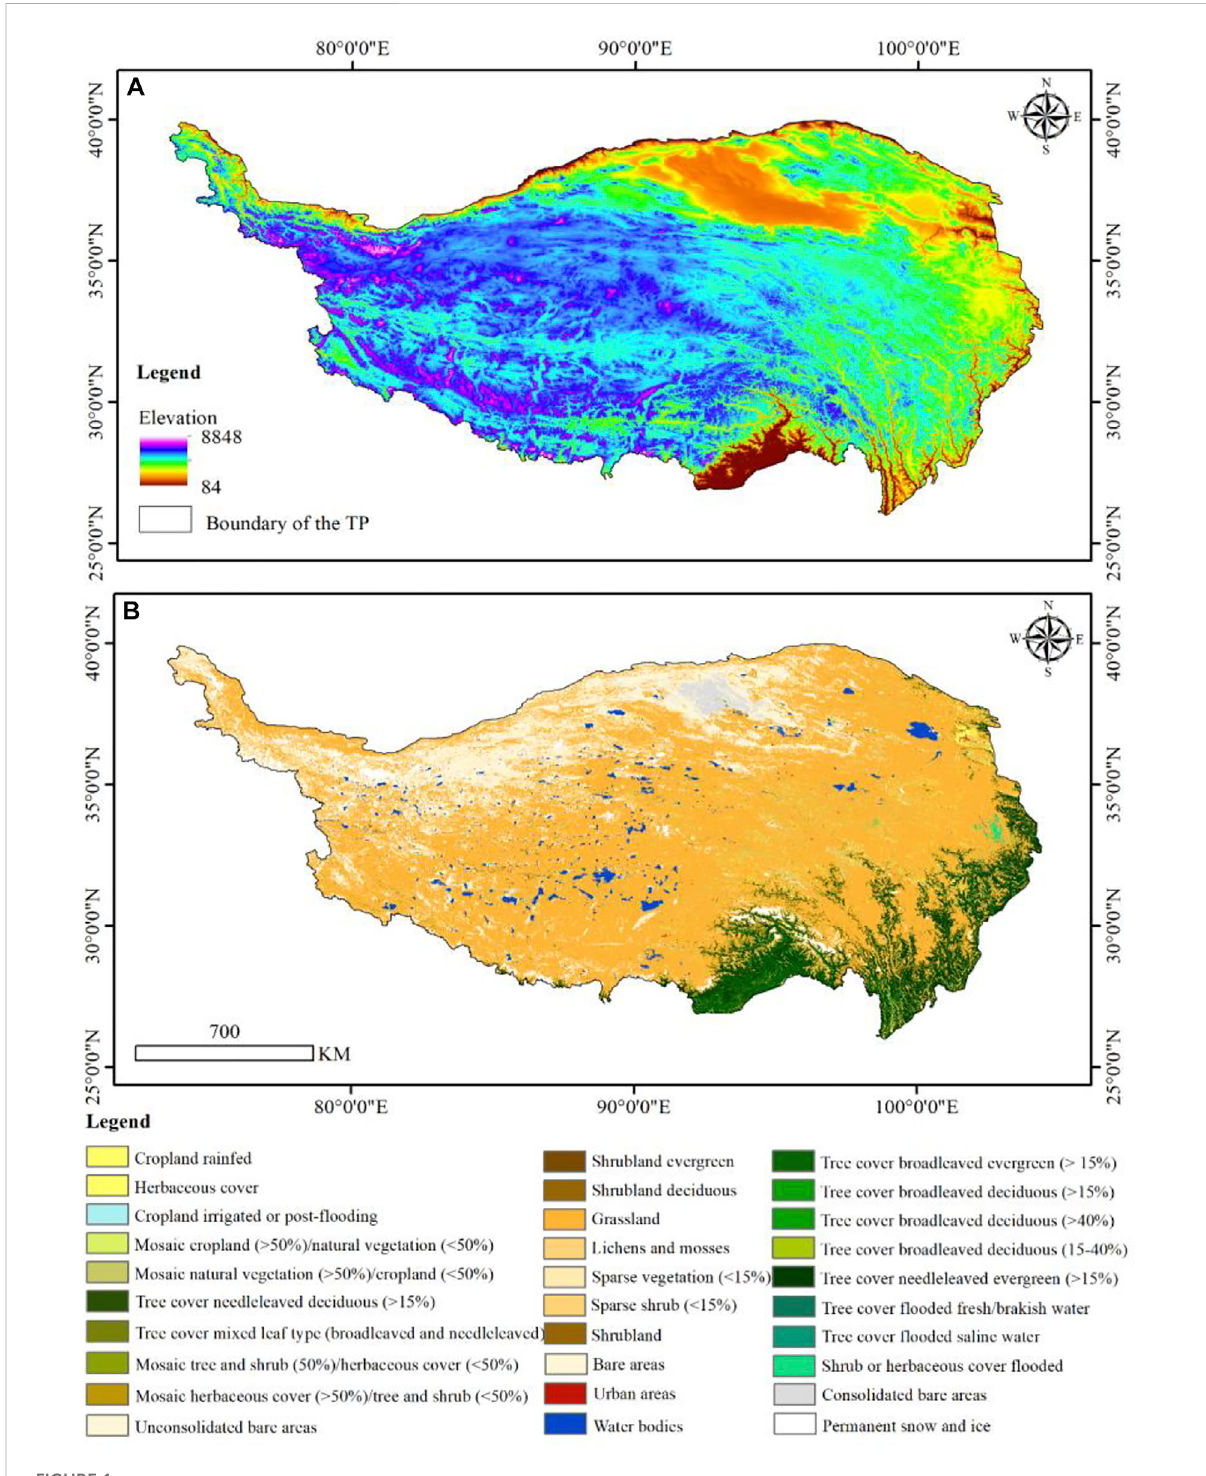
FIGURE 1 (A) Elevation distribution of the TP. This dataset is acquired from the Shuttle Radar Topography Mission (SRTM). For more details about the SRTM, readers are kindly referred to Farr et al. (2007). Moreover, the boundary of the TP is accessed from the National Tibetan Plateau Data Center, China (http://data.tpdc.ac.cn/). (B) Land cover types of the TP in 2017. The land cover data is retrieved from the European Space Agency Climate Change Initiatives Land Cover Project (https://www.esa-landcover-cci.org/). For more information about this dataset, readers are kindly referred to Bontemps et al.